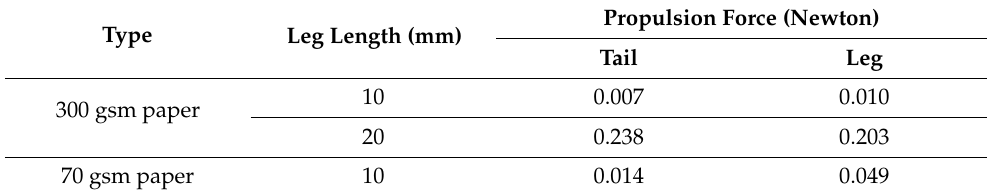
Figure 16. Set-up of propulsion force measurement test using force sensor in the x-direction. A copper string is used to attach the structure to the tip of the force sensor. SLEM structure is actuated by the APM below the test surface. When the structure legs move forward, they pull on the copper string, and the computer monitor registers a propulsion force. Table 6. Propulsion force for different leg lengths and thicknesses of SLEM material for 10 cycles .